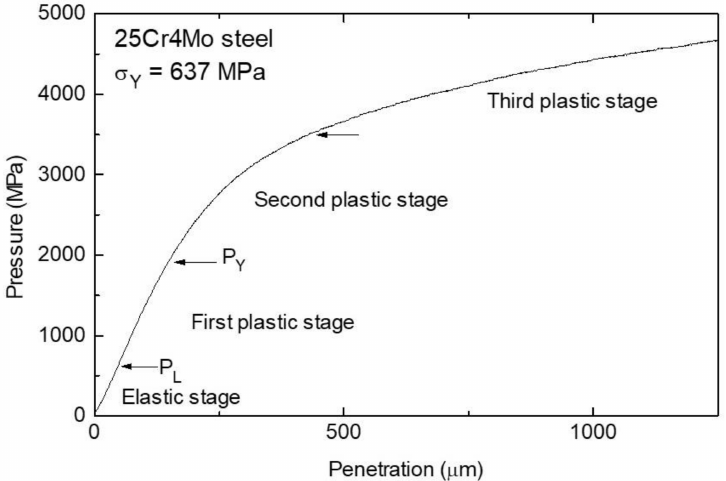
Figure 2. Flat-top cylinder indenter for mechanical characterisation (FIMEC) indentation curve of 25Cr4Mo steel.